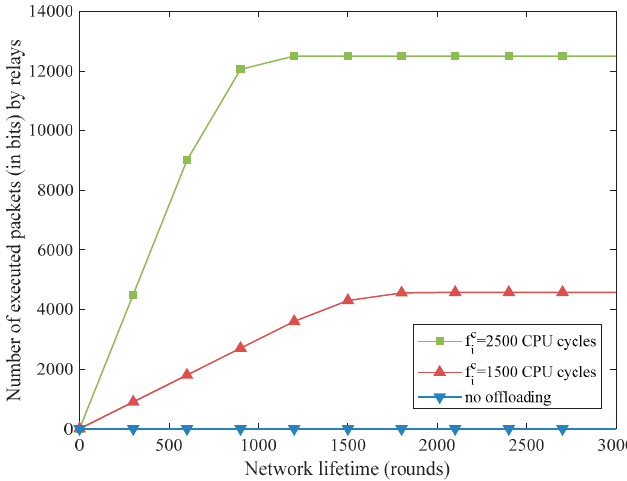
Figure 6. The number of executed packets by relays versus time under different scenarios.